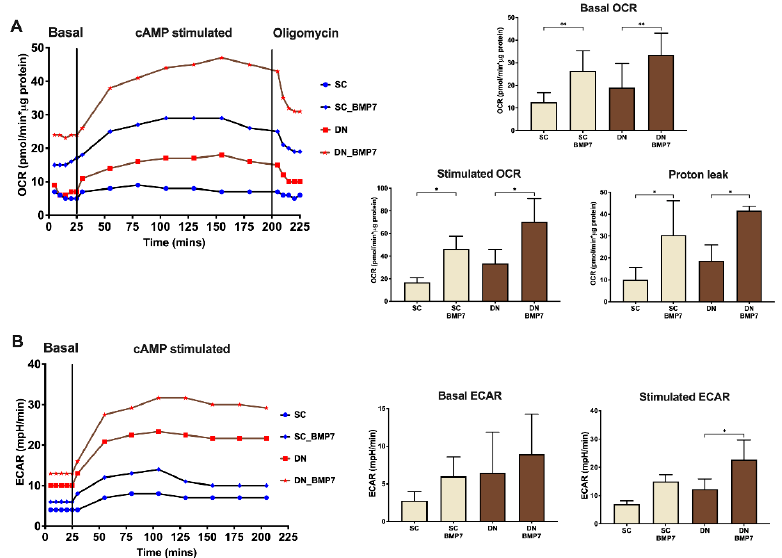
Figure 5. BMP7 treatment resulted in increased cellular respiration, thermogenic response, and extracellular acidification in SC and DN derived differentiated adipocytes. SC and DN preadipocytes were differentiated and treated as in Figures 1–4. ( A ) Representative time lapse curve for measured oxygen consumption rate (OCR) after indicated treatments, followed by quantification of basal, stimulated, and proton leak OCR; ( B ) representative time lapse curve for measured extracellular acidification rate (ECAR) after the indicated treatment, followed by quantification of basal and stimulated ECAR. Data expressed as mean ± SD. n = 4. * p < 0.05, ** p < 0.01. Statistics: one-way ANOVA with Tukey’s post-test.